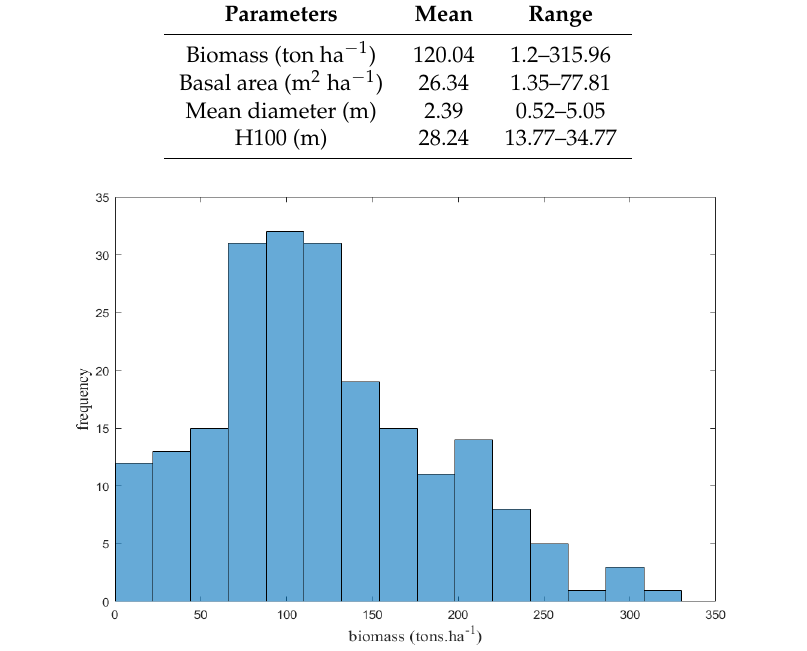
Figure 5. Distribution of forest plot biomass for the 214 plots at the test